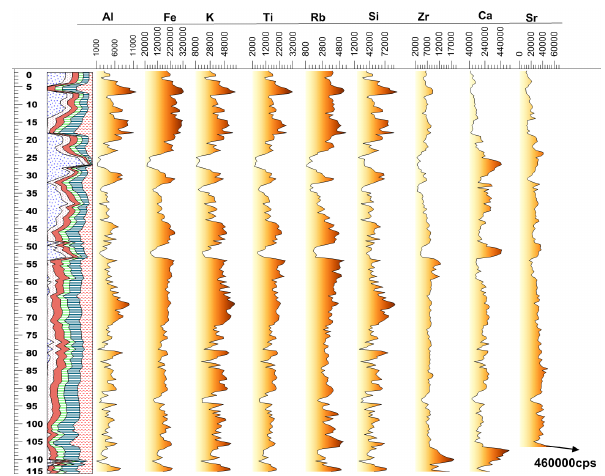
Figure 3. Down-core plots of signal intensity (cps, counts per sec- ond) vs. depth in MC45 of nine geochemical